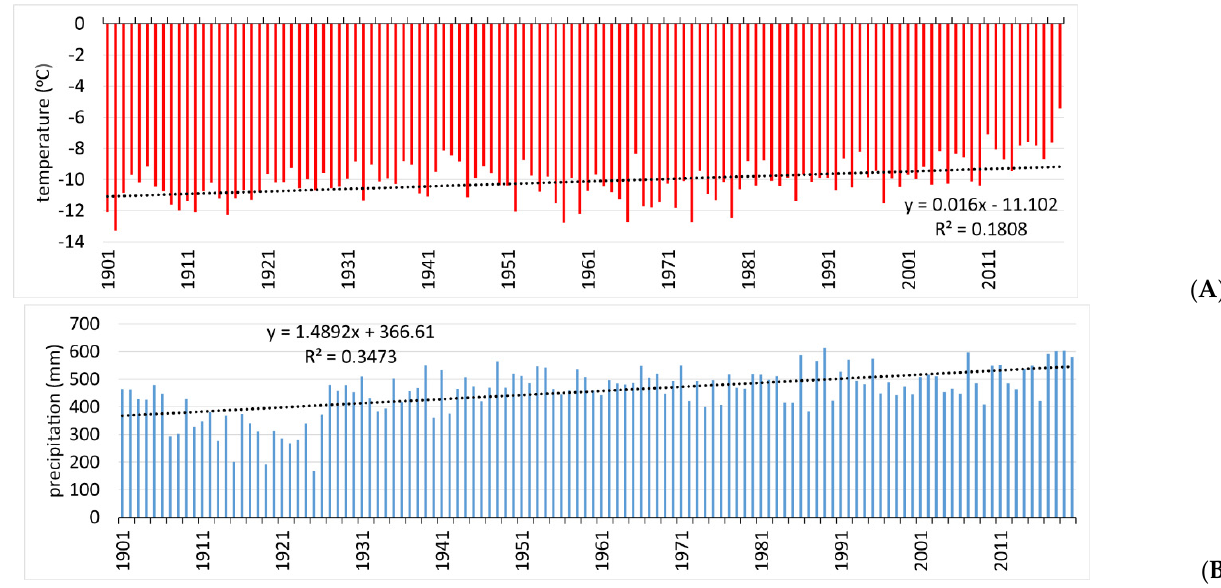
Figure 6. ( A )Annual mean temperature, ( B ) precipitation totals and linear trends. Data derived from gridded CRU TS database v. 4.